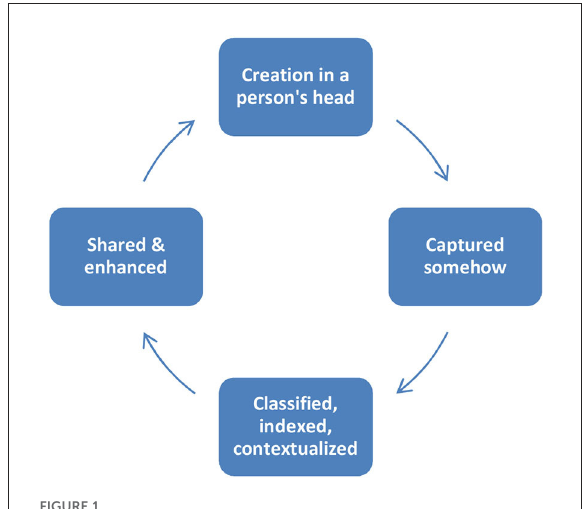
FIGURE1 Bock’s knowledge creation cycle (Bock et al.,